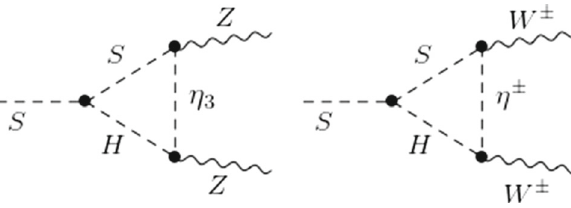
Fig. 3 Examples of the Feynman diagrams contributing to the mixing angle dependence of R SSM